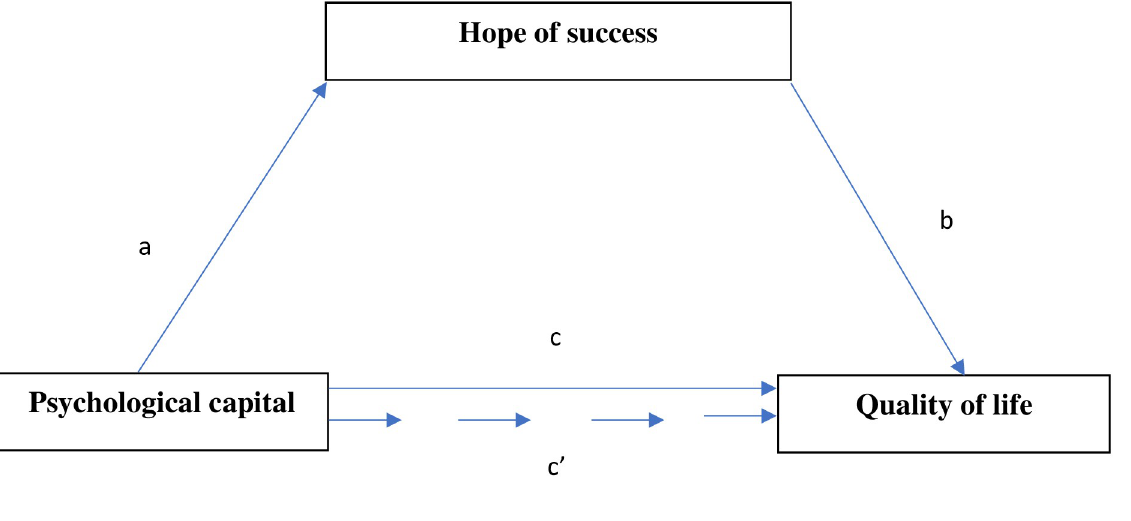
Fig 1. General mediation model.